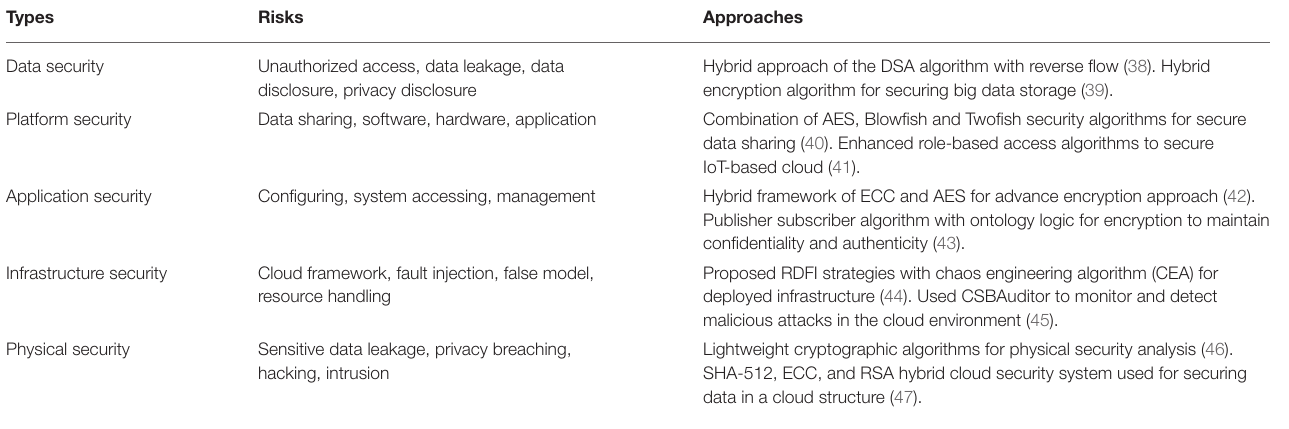
TABLE 2 | Recent research on network security risks.